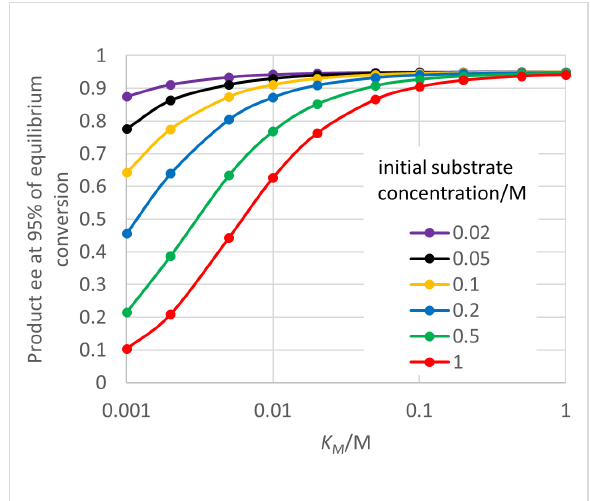
Figure 6: Effects of prochiral substrate concentration and its K M value for “ping-pong, first” kinetics. Input parameters were: K eq = 15 M, E = 39, k 4 = 1000 s − 1 , SCRf / b = 5, k 2R / k 4 = 1, k 2R / E · k 2S = 1, k 3 · [H 2 O]/ k 4 = 1, k − 4 · K eq / k 4 = 1 , k − 1R / k − 3 = 1, E · k − 1S / k − 3 = 1. The K eq here is defined omitting the water concentration, so has units. For a diol ester hydrolysis, K eq will probably depend significantly on the po- sitions of the hydroxy groups with respect to each other. A value around 40 M was found for glycerol dioctanoate [35].